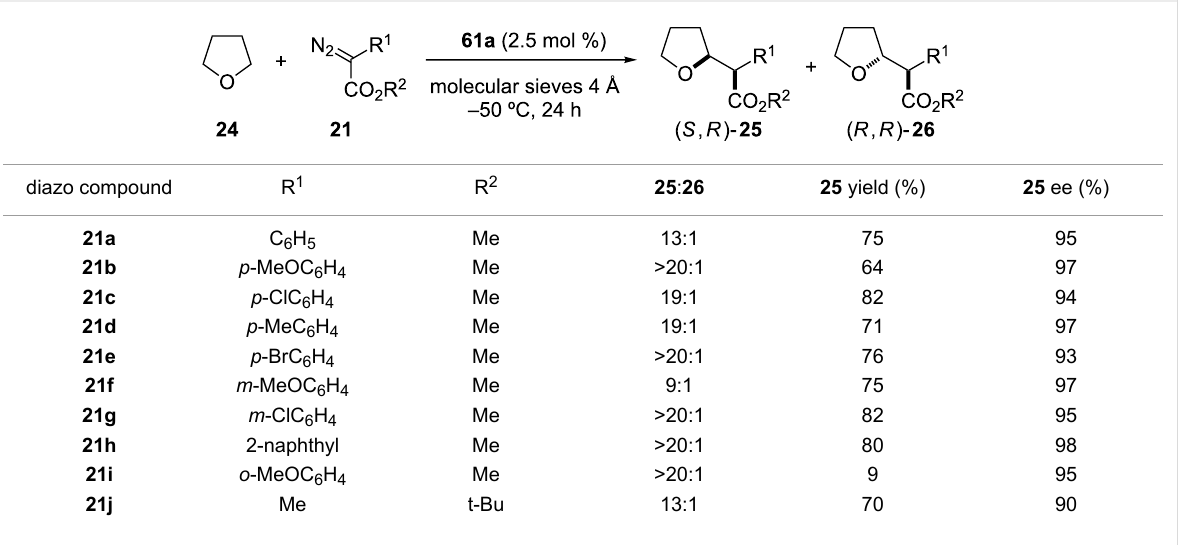
Table 8: Intermolecular insertion of chiral iridium carbenoid into THF C(sp 3 )–H bond.